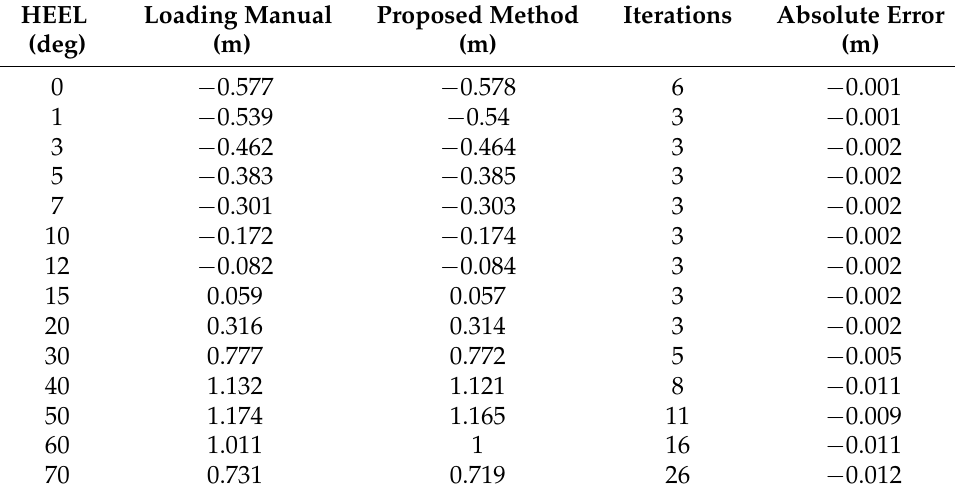
Table 12. GZ calculation result of INI16-DAM09.